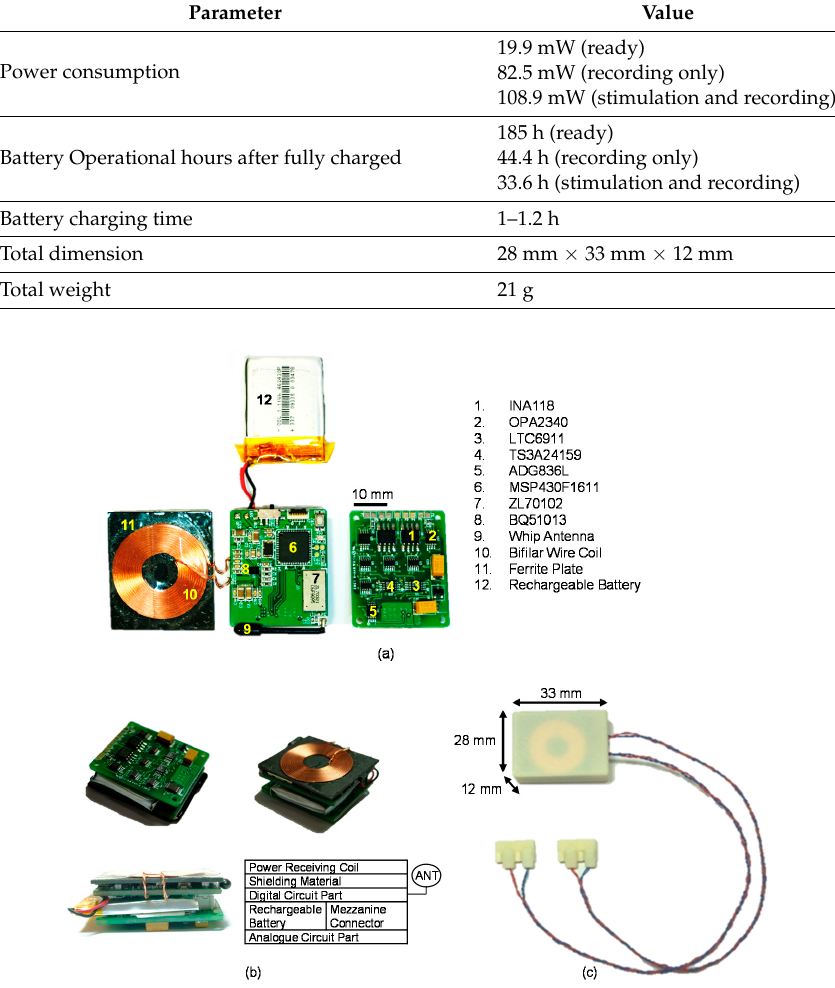
Figure 16. Photograph of the implantable device: ( a ) disassembled view and key components of the implantable device, ( b ) assembled view and ( c ) encapsulated implantable device and cuff electrodes by bio-compatible PolyJet photopolymer (MED610).